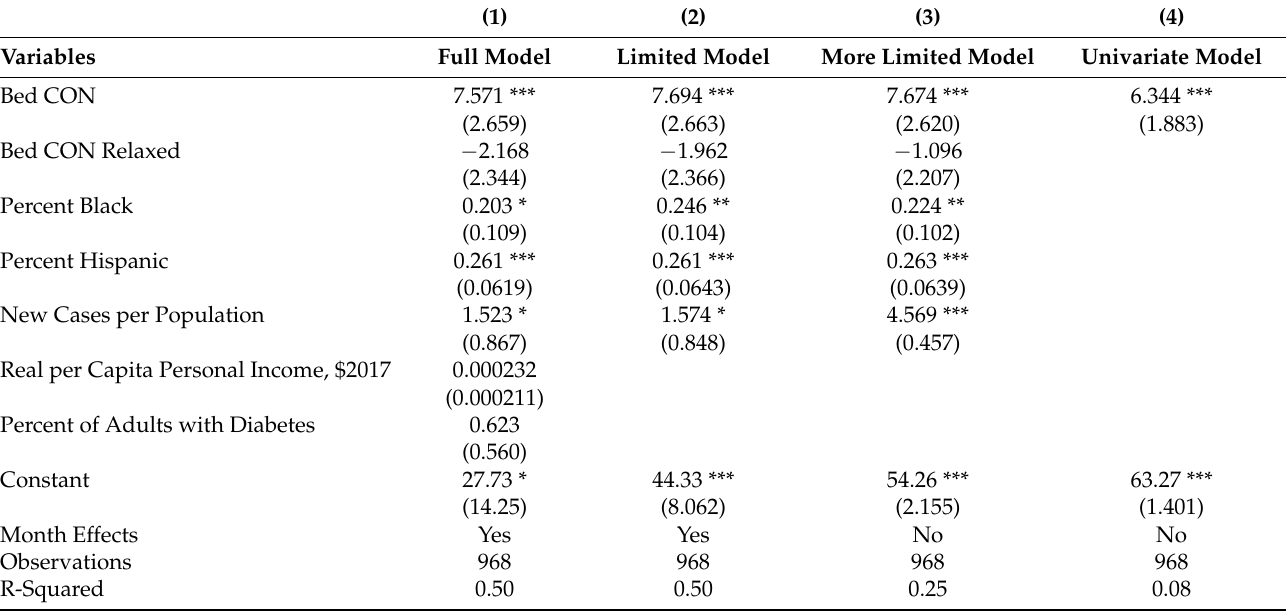
Table 5. Modeling Average Share of Beds Used per Month per State.